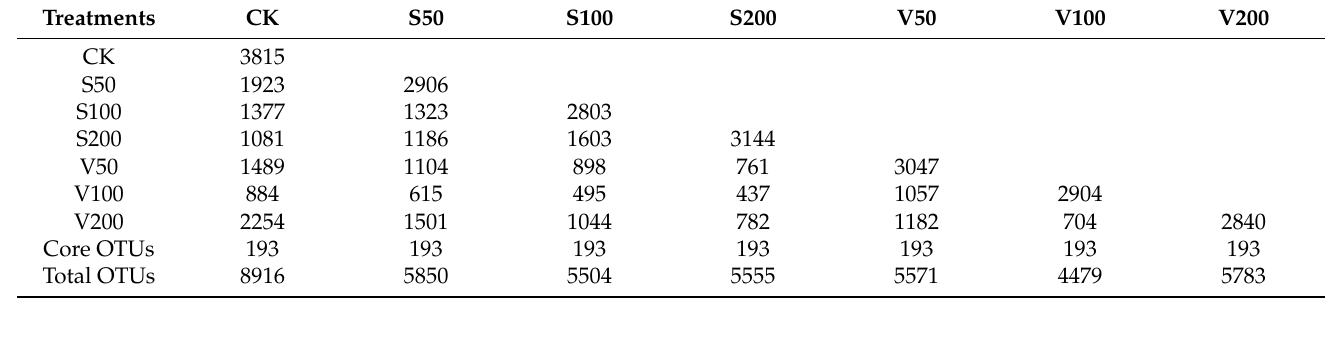
Table 1. The number of core and unique OTUs in different treatments.